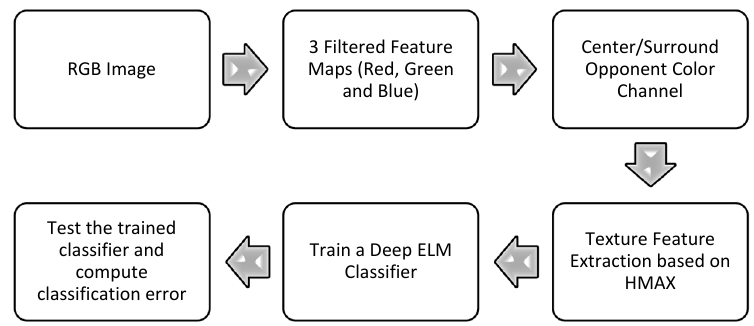
Figure 1. Flowchart of the proposed algorithm.